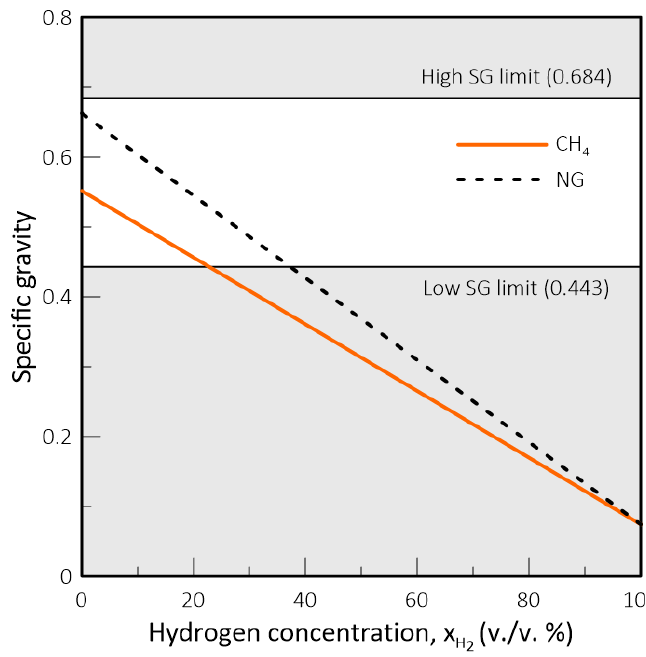
Figure 5. Specific gravity of NG and CH